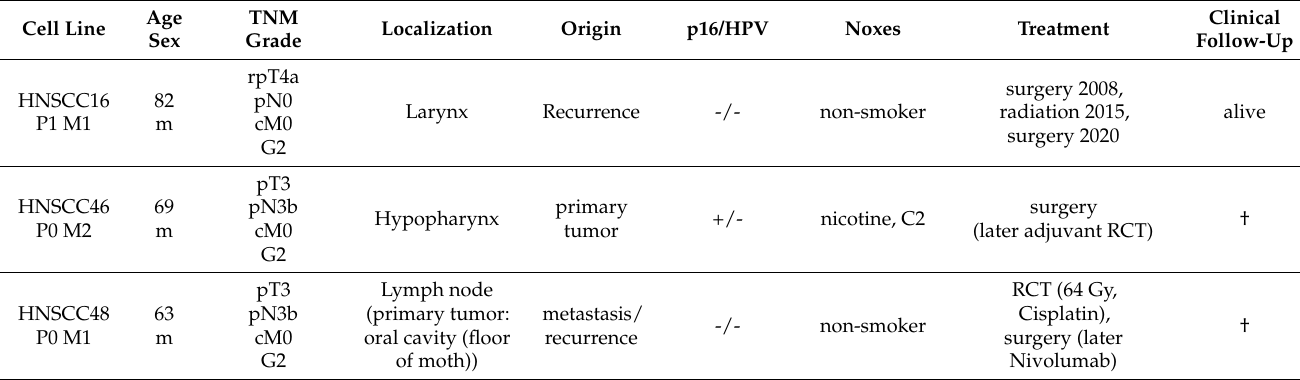
Table 1. Clinical